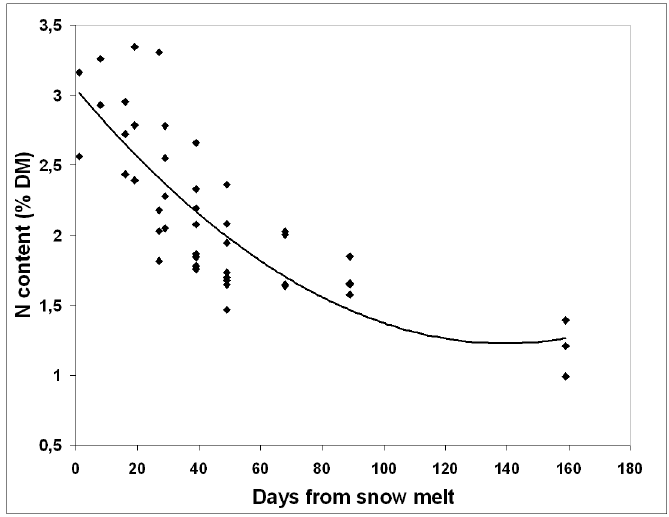
Fig 3. Relationships between days from snowmelt and N content of the main woody species of ptarmigan diet. All species and site samples pooled. Line corresponds to a quadratic adjusted model (see